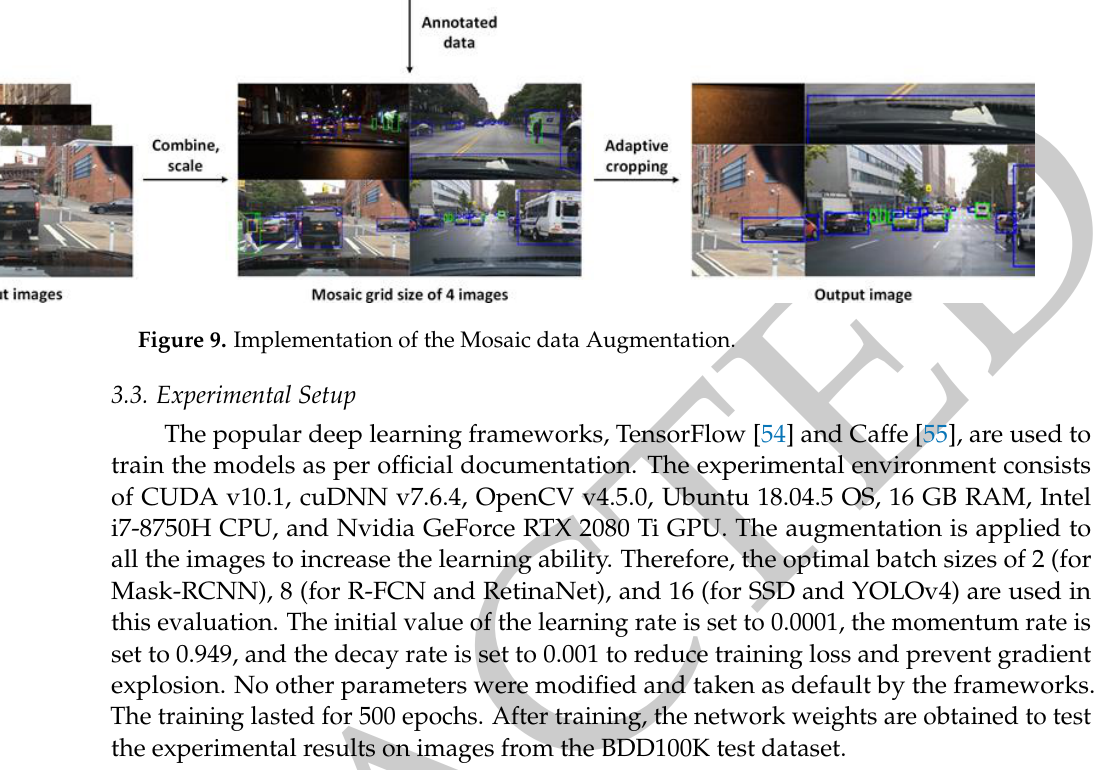
Figure 8. Data augmentation methods ( a ) original image ( b ) displacement ( c ) horizontal flipping ( d ) random cropping ( e ) motion blurring ( f ) random noise adding.